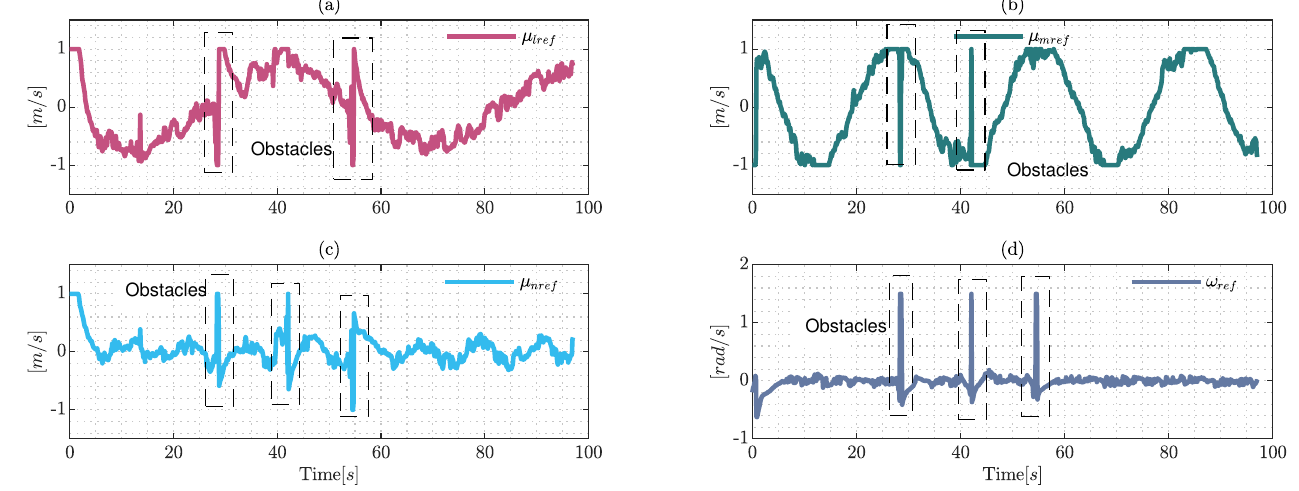
Figure 17. Control signals generated by the proposed control and maneuverability velocities were generated by the dynamic approximation, where ( a ) represents the maneuverability velocities over the axis { I x } ; ( b ) describes the evolution of velocities in evolution of the upper and angular velocity,